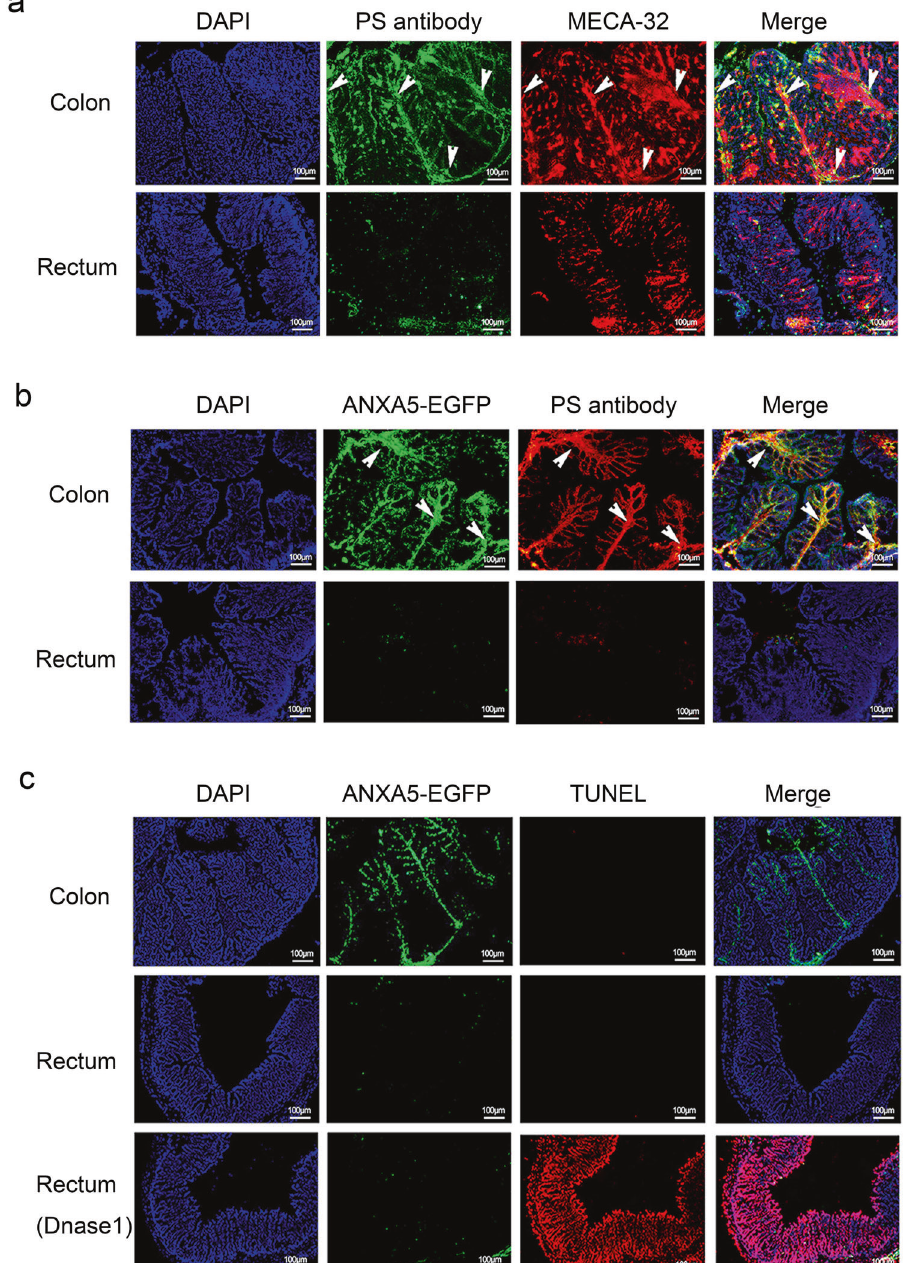
Fig. 1 PS exposure on the surface of colonic capillaries. a Normal C57BL/6 mice were received anti-PS antibody by tail vein injection. The sections of colon and rectum were stained for anti-PS antibody in green and MECA-32 in red. Representative images showed the staining of exposed PS co-localized with MECA-32. b Mice were injected intravenously with ANXA5-EGFP and anti-PS antibody. The sections of colon and rectum were prepared after 30 min of injection. Anti-PS antibody was stained in red with AF594-conjugated secondary antibody. The yellow in merged image indicate the co-location of ANXA5-EGFP and anti-PS antibody. c After intravenous injection of ANXA5-EGFP, the intestinal sections were prepared for TUNEL assay. Dnase I treatment as a positive control. Data are representative of more than three experiments ( n = 3 mice/group). Scale bars: 100 μ m. Arrows pointing to the co-location of dual fl